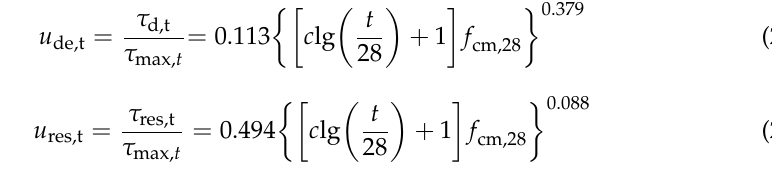
Figure 10. The strength ratios of steel fibers in M40, M31 and M24: ( a ) u de,t; ( b ) u res,t . Based on the Formulars (21)–(23), the formulas of u de,t and u res,t can be expressed as Formulas (23) and (24). The average ratios and corresponding variation coefficients of calculated to the tested values of the strength ratios for steel fibers in M40, M31 and M24 are listed in Table 5.